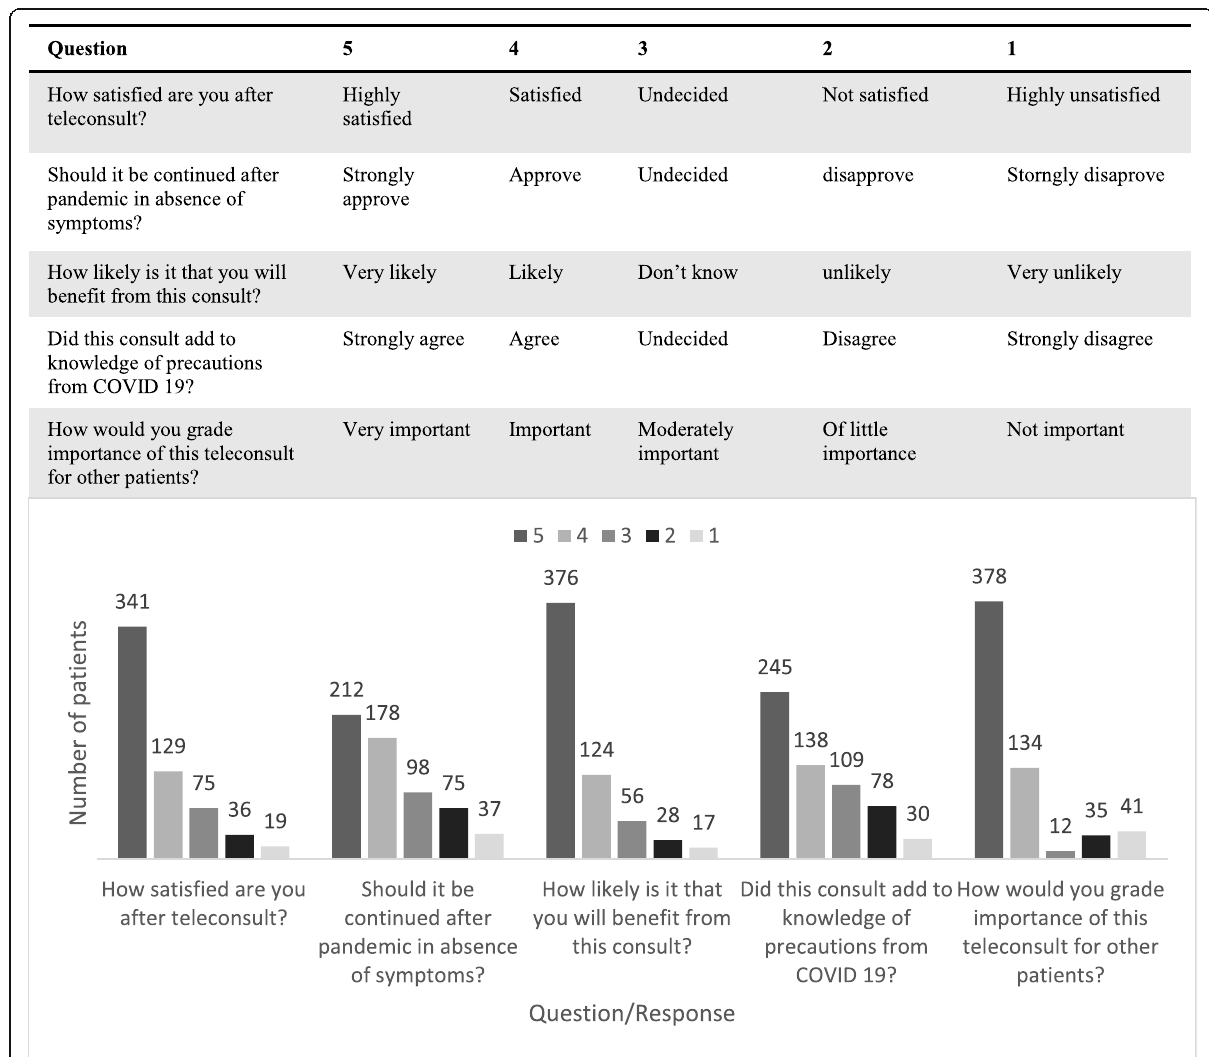
Fig. 3 Various responses to questions in the questionnaire as given by patients during telemedicine consult (COVID-19, coronavirus